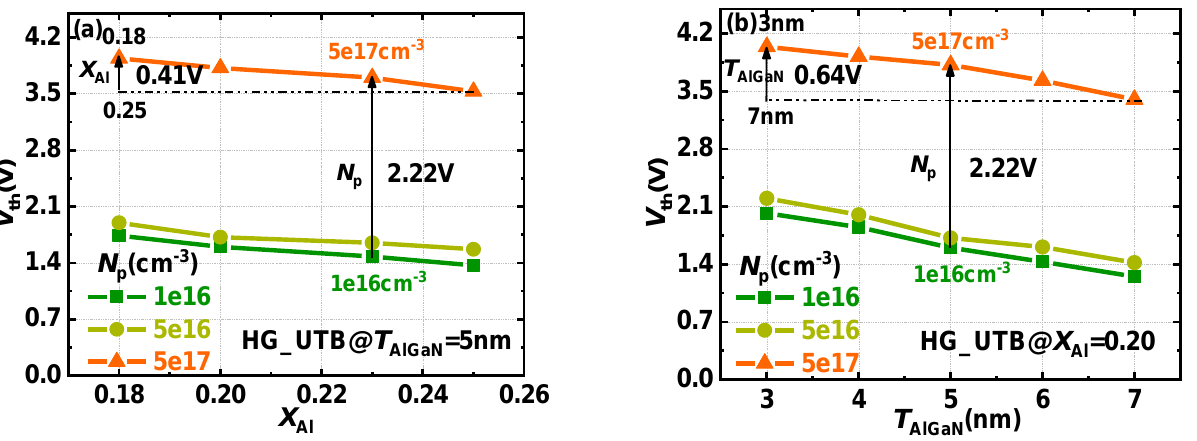
Figure 5. V TH modulation of HG − UTB HEMTs with various N p ( a ) and Al − mole fractions ( X Al ) ( b ) and thicknesses ( T AlGaN ).